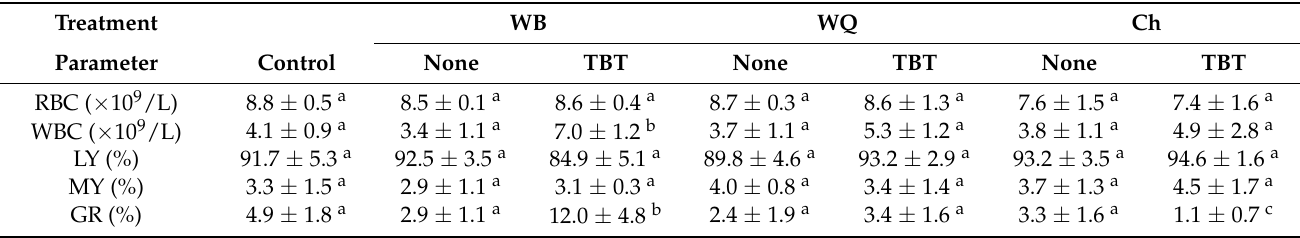
Table 2. Total red blood cells (RBC) and leukocyte (WBC) counts, and lymphoid (LY), myeloid (MY), and granulocytes (GR) percentages (%) in peripheral blood of wild type animals and those perinatally-exposed to tributyltin. Wheat bread (WB), white quinoa bread (WQ) and chia bread (Ch). Results are expressed as mean ± standard deviation ( n = 5–6). Different superscript letters (a–c) indicate statistical differences ( p < 0.05).